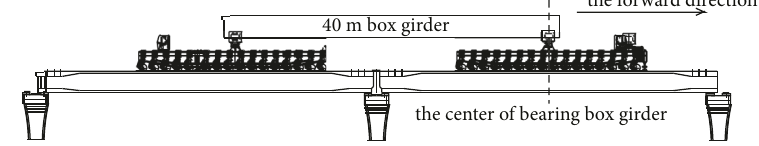
Figure 5: The most unfavorable condition of box girder Table 1: Material parameters.